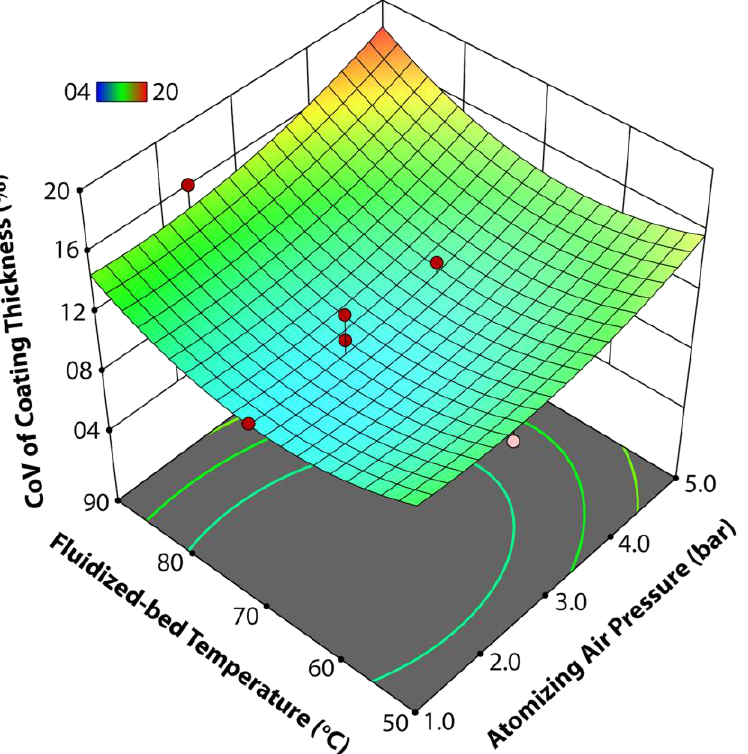
Figure 5. Interactive effect of the fluidized-bed temperature ( T fb ) and atomizing air pressure ( P air ) on the coefficient of variance (CoV) of the coating thickness.